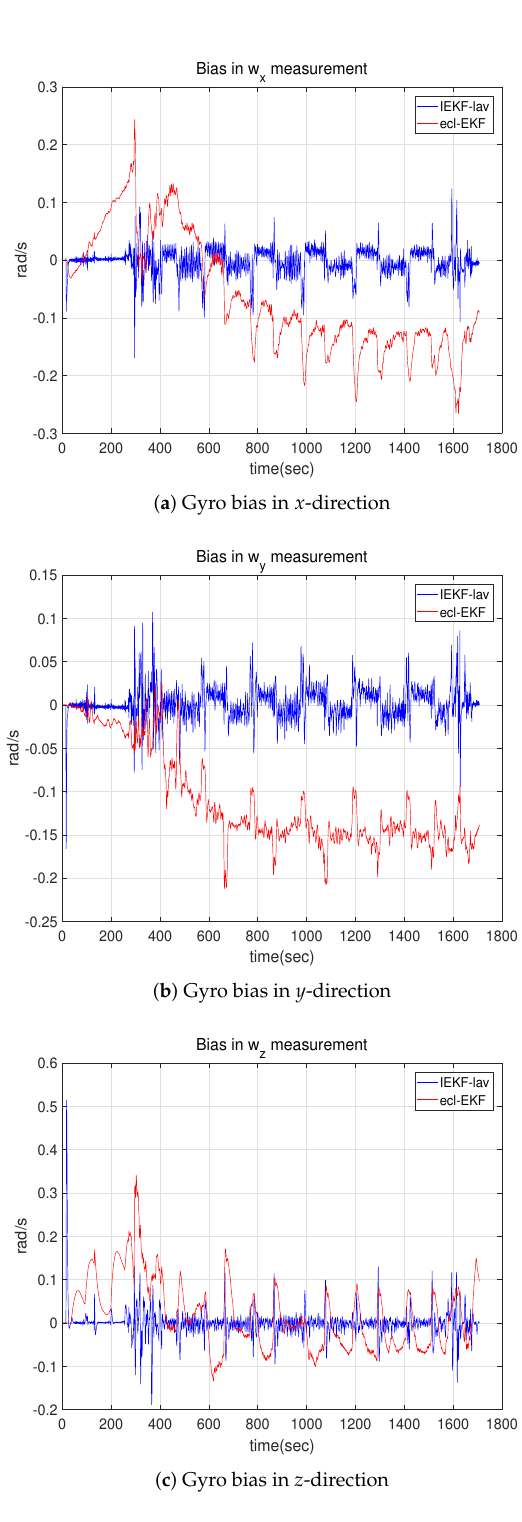
Figure 6. Bias in angular rate measurement by gyro estimated by IEKF-lav and